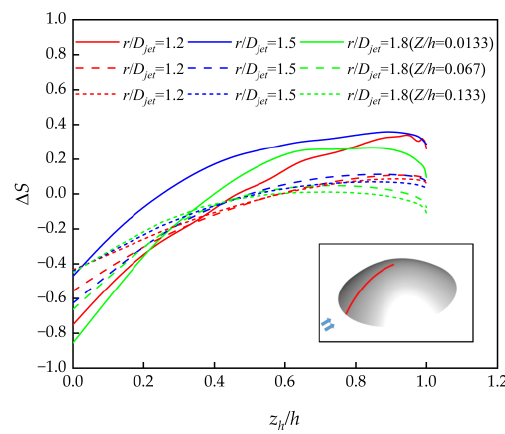
( b ) Dimensionless speedup ratios at different heights